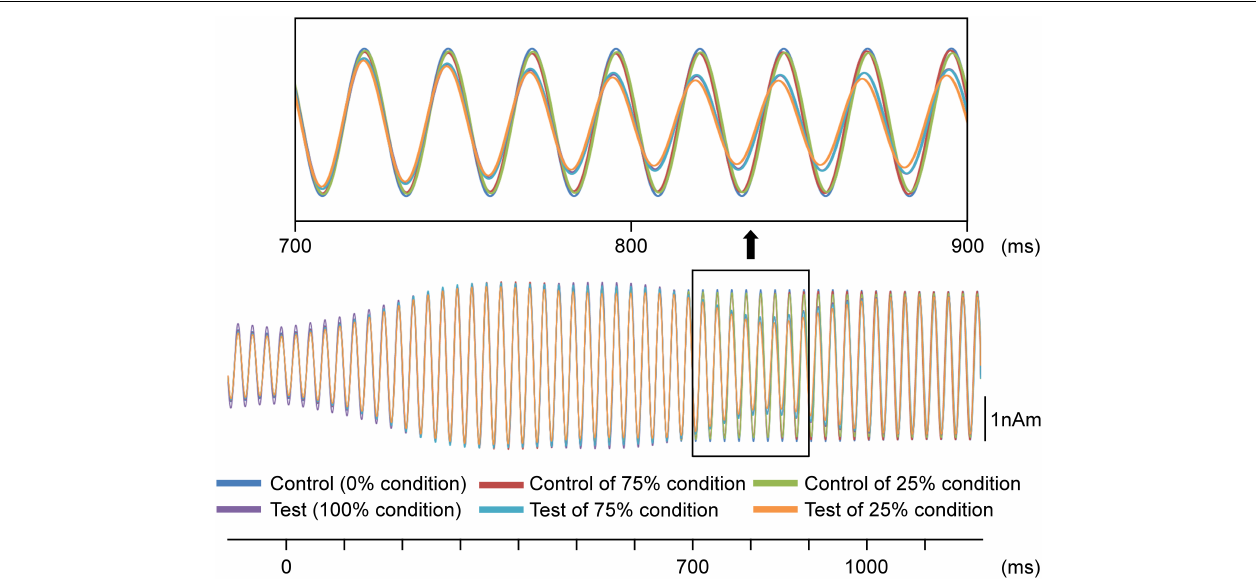
FIGURE 3 | Effects of the probability on auditory steady-state response (ASSR). Grand-averaged waveforms across 13 participants are shown. Probability refers to that for the test stimulus.